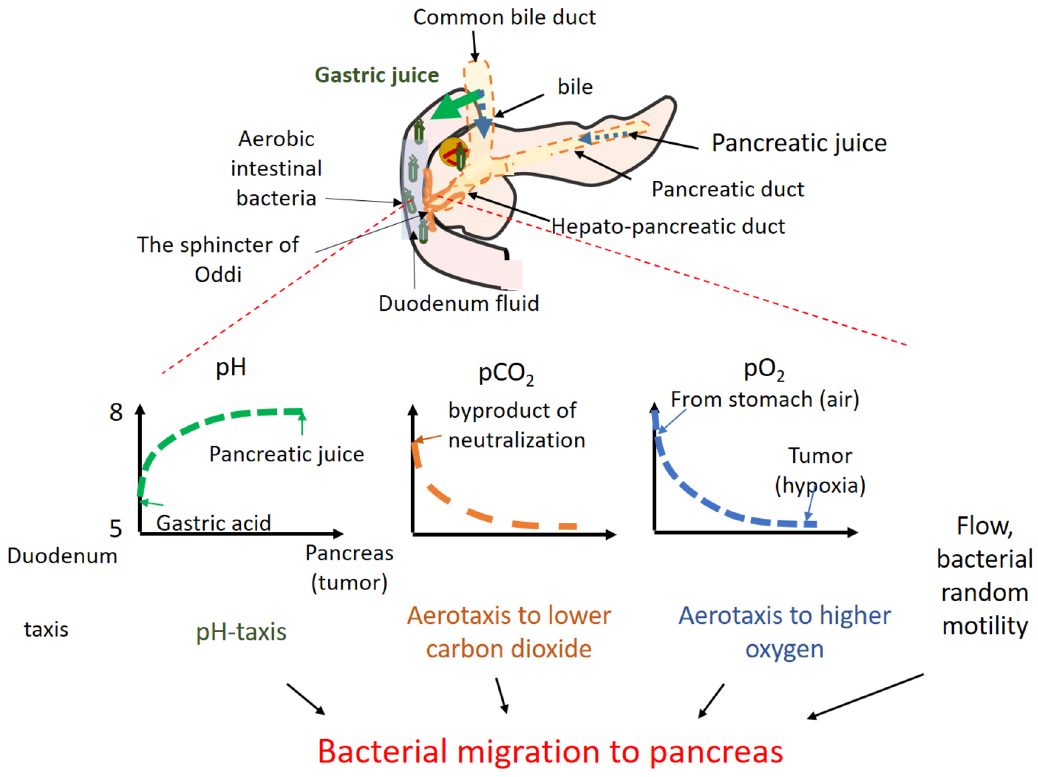
Figure 1. This work aims to understand how environmental factors in hepato-pancreatic duct such as pH, carbon dioxide and oxygen concentration, and fluid flow contribute to migration of aerobic bacteria from the duodenum to the pancreas with